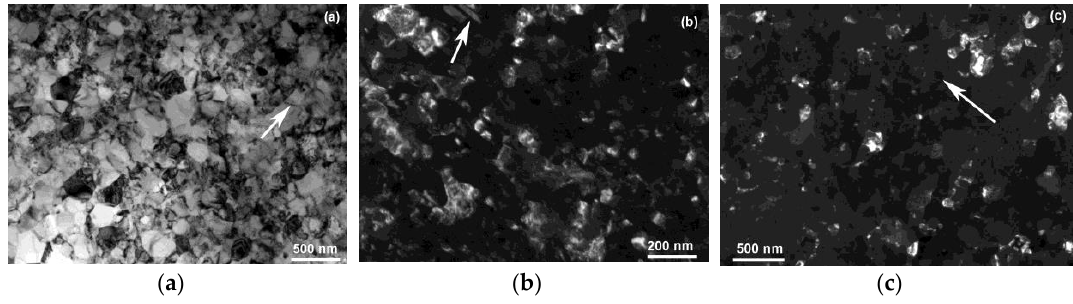
Figure 1. Transmission electron microscope (TEM) micrographs of samples after high-pressure torsion (HPT)-treatment and before heating in differential scanning calorimeter (DSC) calorimeter. ( a ) Cu-5 wt.% Co, bright field, ( b ) Cu-2.8 wt.% Ag, dark field, ( c ) Cu-77 wt.% Ni, dark field. Some microtwins are shown by the arrows.